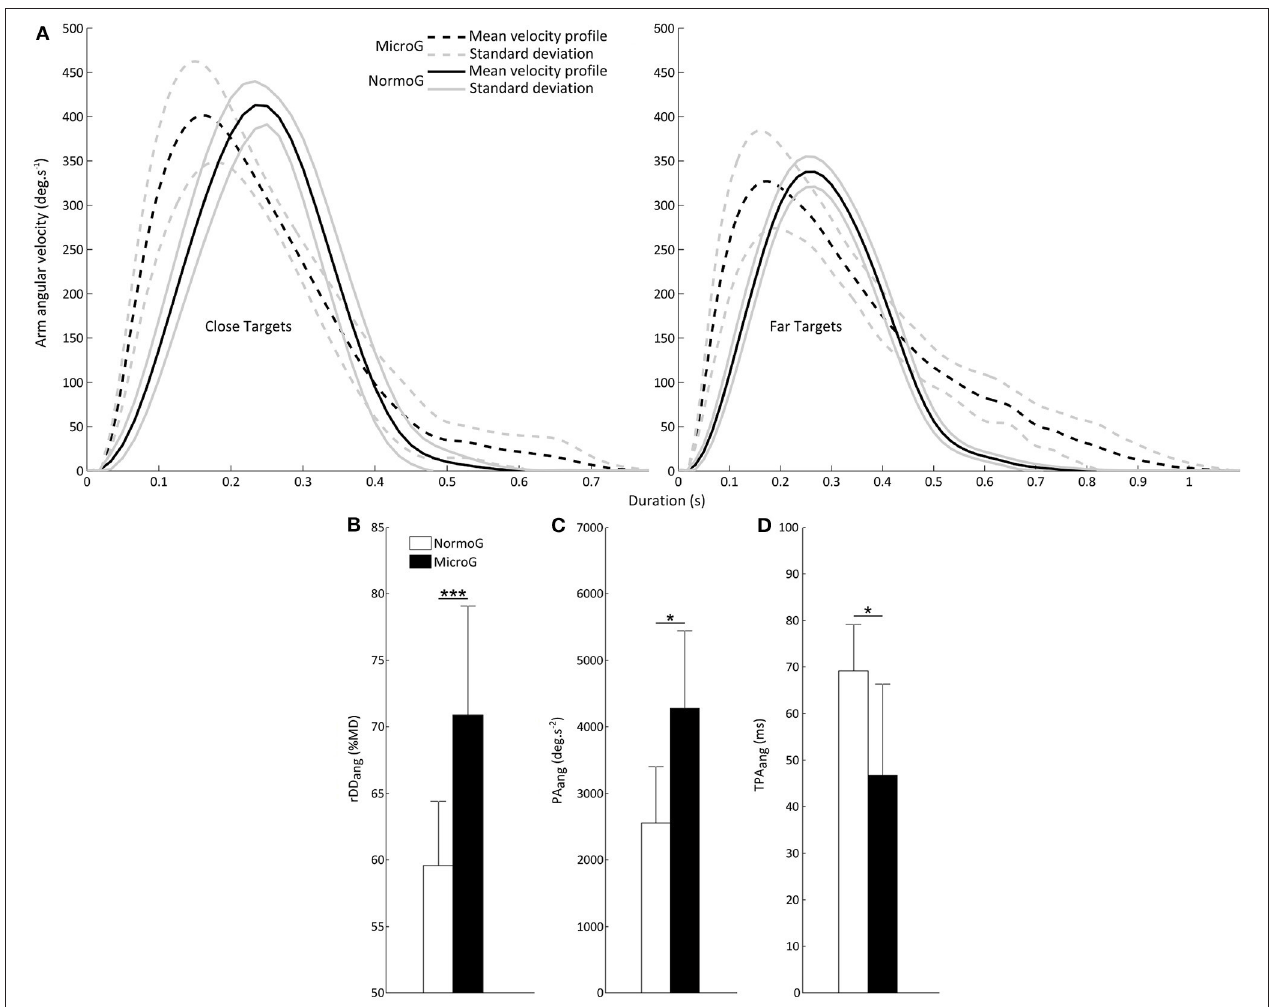
FIGURE 3 | (A) Representative mean arm angular velocity profiles for a typical subject in MicroG (dotted line) and NormoG (solid line) for the Close and Far targets. Gray lines represent the positive and negative standard deviations of the mean arm angular velocities. (B) Mean relative angular deceleration duration (rDD ang ) as a function of Environment. (C) Mean peak angular acceleration (PA ang ) and (D) Mean time to peak angular acceleration (TPA ang ) as a function of Environment. Error bars represent standard deviation of the mean. *** p < 0.001; * p <